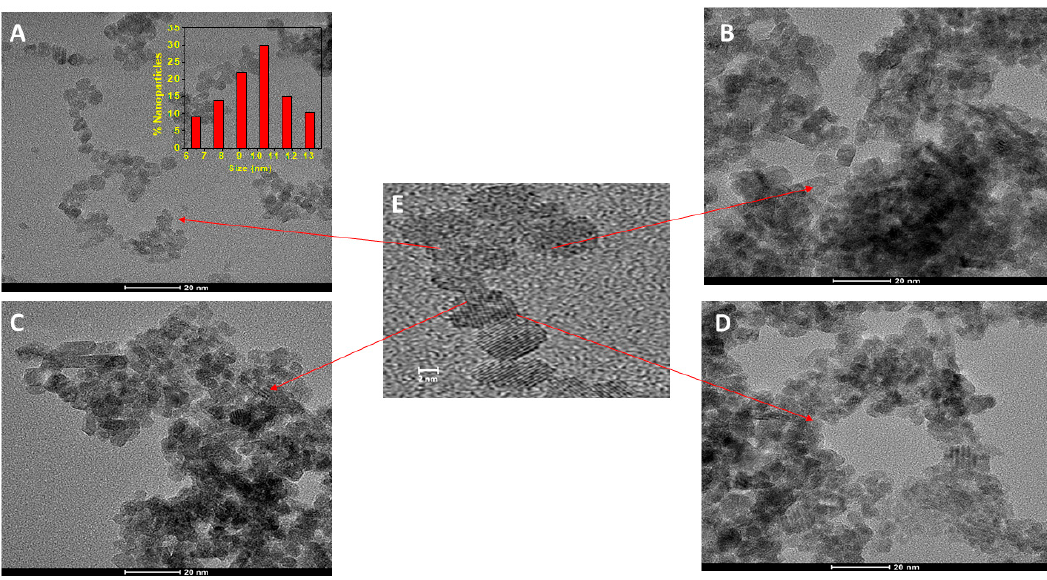
Figure 1. Transmission electron microscopy (TEM) images of the obtained nCeO 2 : ( A ) Uncoated cerium-oxide nanoparticles (nCeO 2 ), ( B ) G-CeO 2 , ( C ) L-CeO 2 , and ( D ) P-CeO 2 . ( E ) Magnified high-resolution transmission electron microscopy (HRTEM) image of the lattice space in the nCeO 2 . Histogram of nanoparticles size distribution is shown as the inset in ( A ).